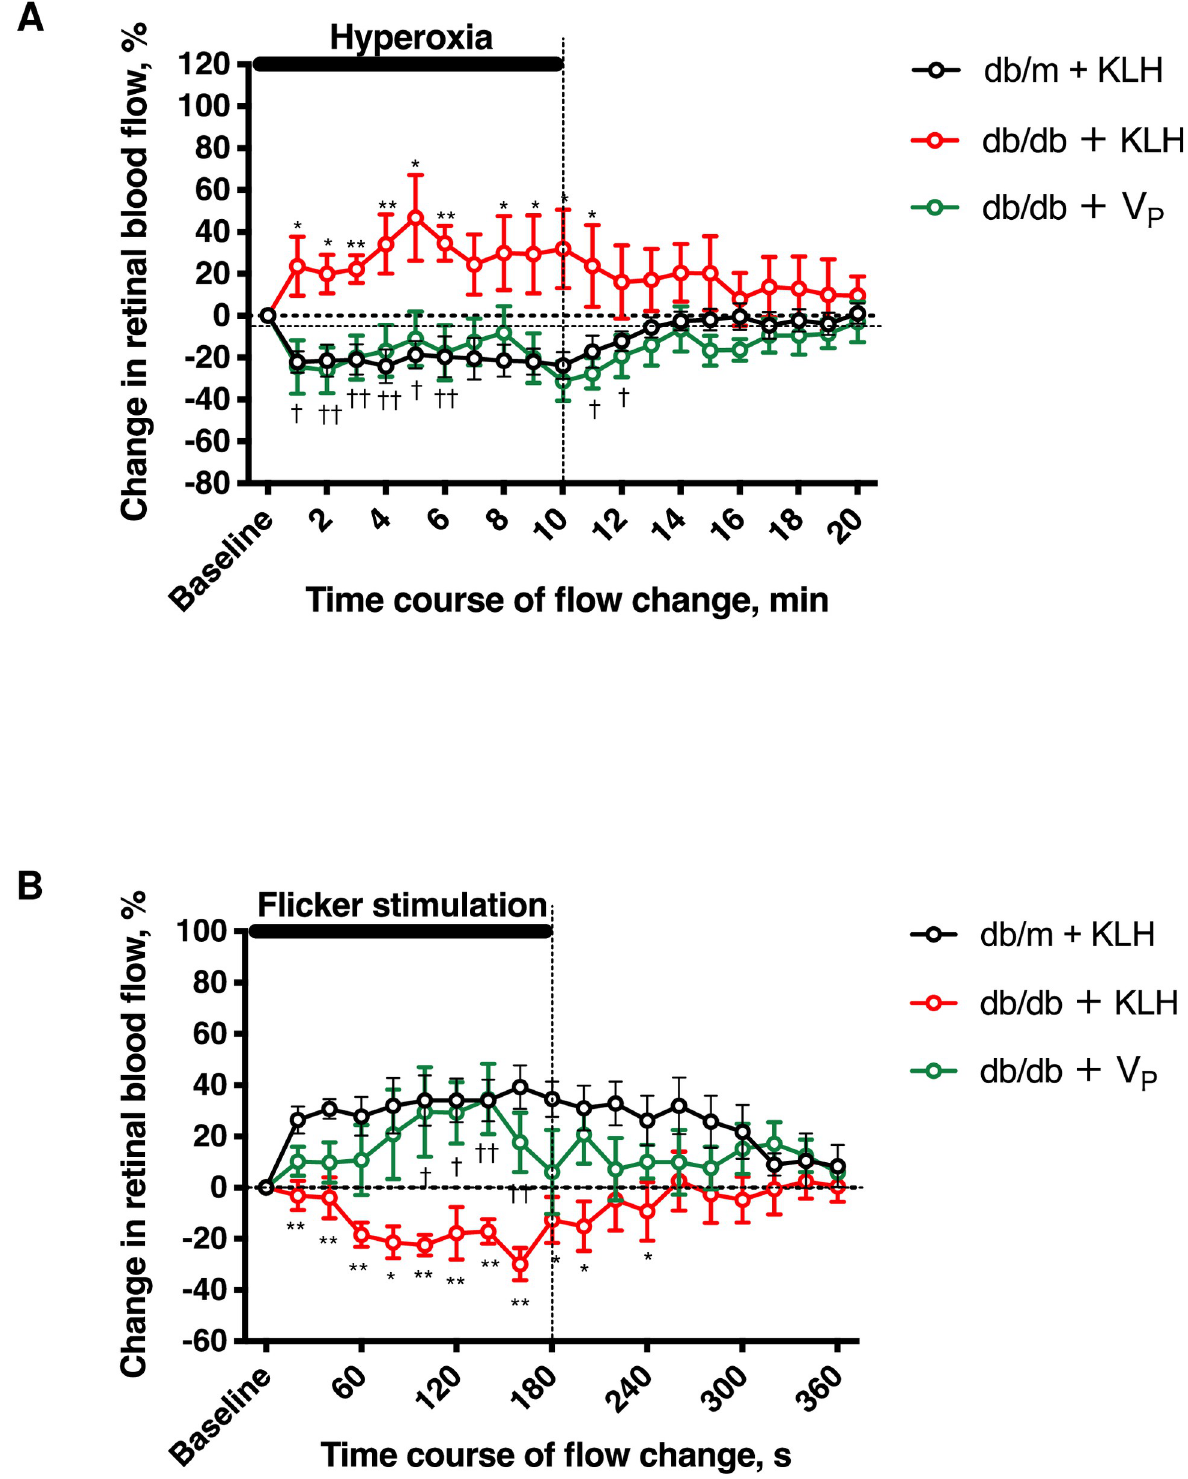
Fig 4. Effect of prorenin peptide vaccine (V P ) on glial dysfunction. (A) Effect of V P on retinal blood flow response to hyperoxia stimulation at 12 weeks of age. (B) Effect of V P on retinal blood flow response to flicker light stimulation at 14 weeks of age. KLH, keyhole limpet hemocyanin; V P , prorenin peptide vaccine. � p < 0.05, �� p < 0.01 vs. db/m + KLH, † p < 0.05, †† p < 0.01 vs. db/db + KLH, NS = not significant. N = 6 in each group.